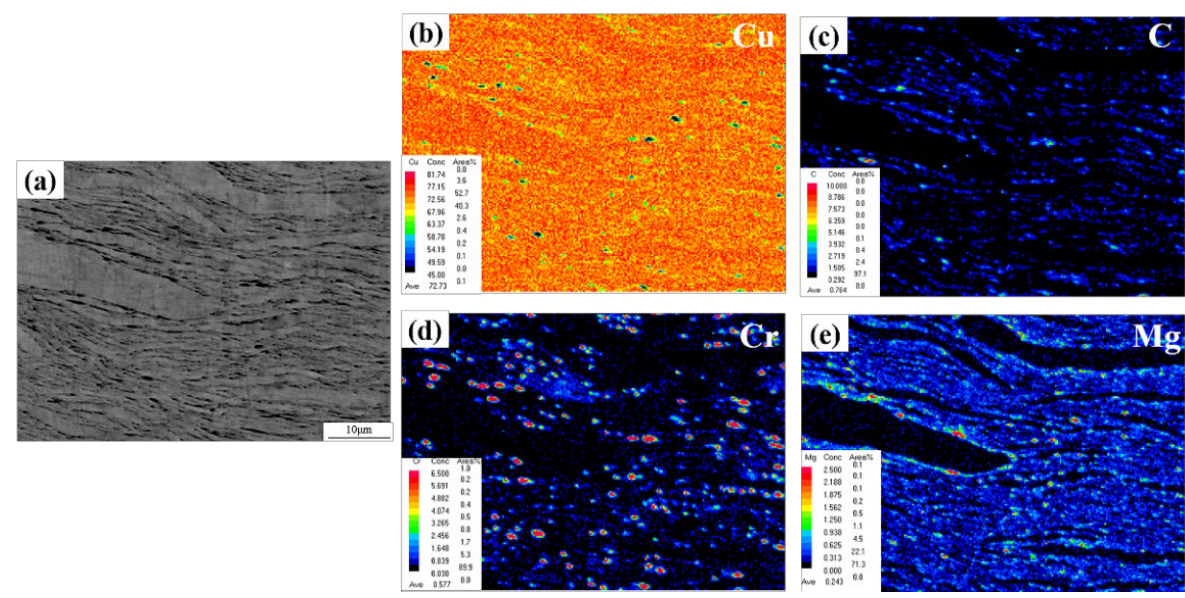
Figure 5. EPMA of a GNPs/Cu–Cr–Mg composite material; ( a ) SEM of a GNPs/Cu–Cr–Mg composite, ( b ) elemental mapping of Cu in ( a ), ( c ) elemental mapping of C in ( a ), ( d ) element mapping of Cr in ( a ) and, ( e ) elemental mapping of Mg in ( a ).